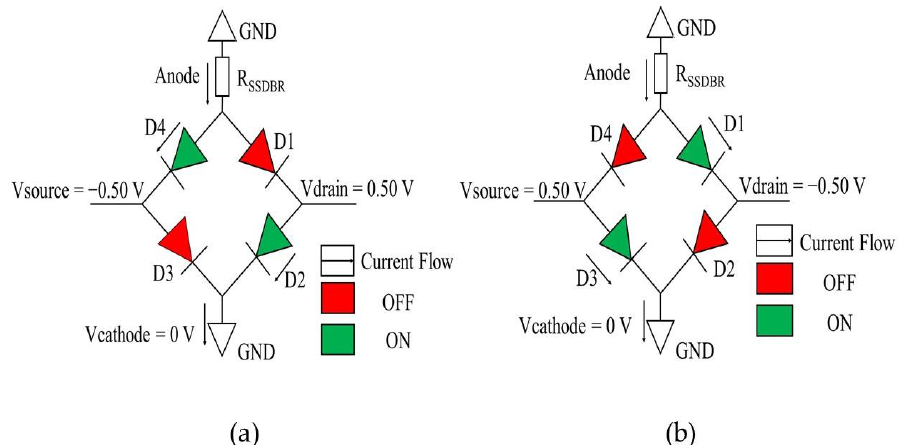
Figure 5. The equivalent circuit for different biasing applied to the bridge rectifier in ( a ) positive cycle and ( b ) negative cycle.